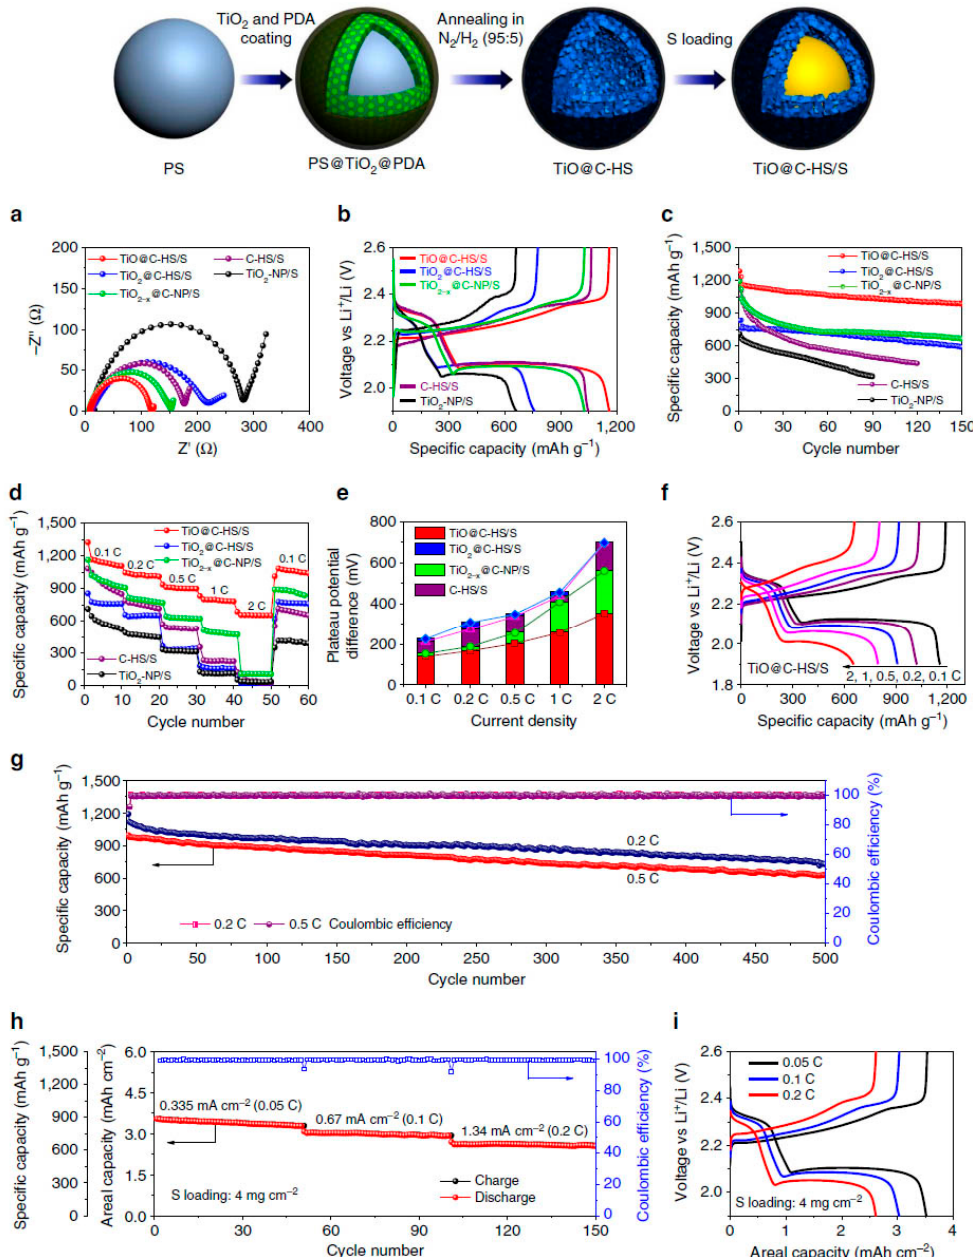
Figure 8. Schematic illustration of the synthesis process and electrochemical properties of TiO@C-HS/S composites. ( a ) Nyquist plots before cycling from 1 MHz to 100 mHz; ( b ) the second-cycle